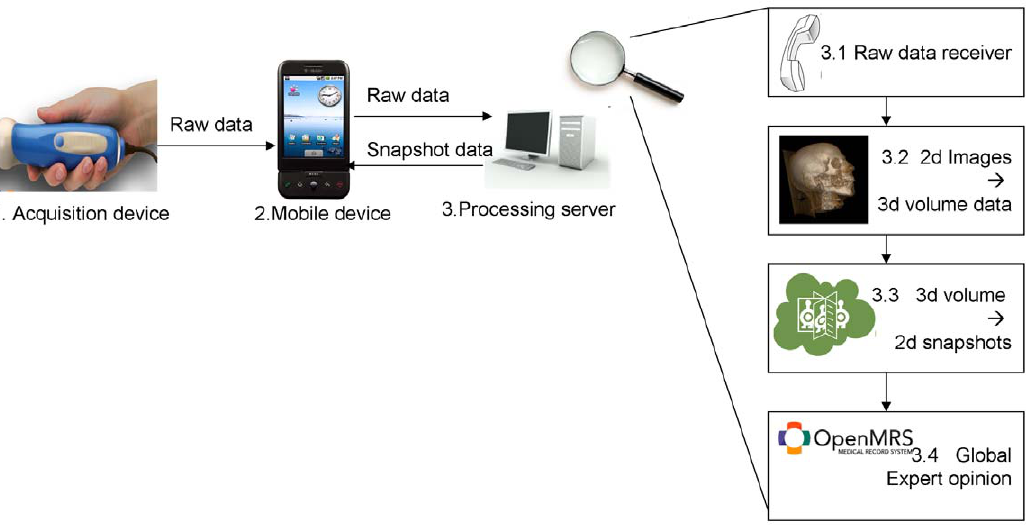
Figure 6. Data flow. The raw data flows from the hardware acquisition device to the mobile console which acts as a storage and communication conduit. Once the data is processed on the server, the results are transferred back to the console for review and